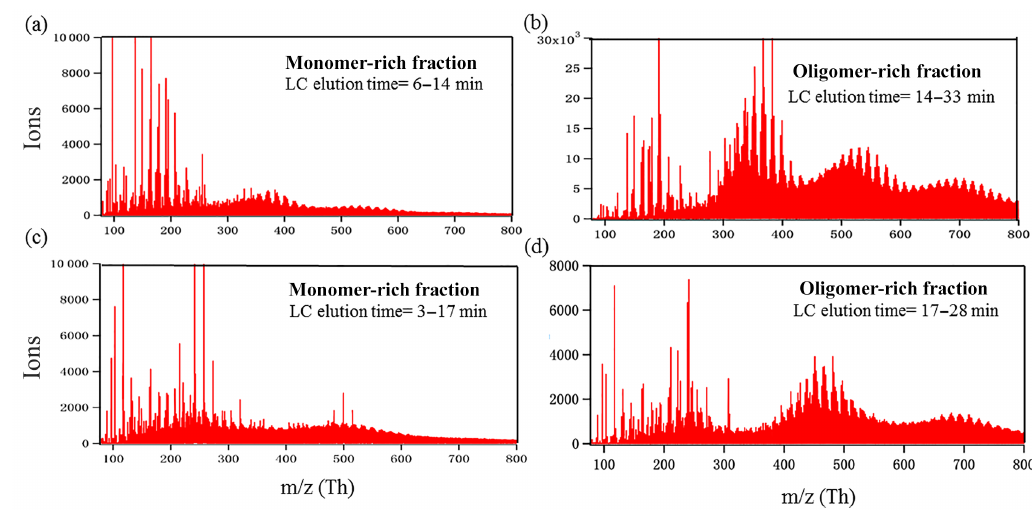
Figure 4. IMS-TOF mass spectra for (a) monomer-rich fraction and (b) oligomer-rich fraction in NSOA, and for (c) monomer-rich fraction and (d) oligomer-rich fraction in PSOA. During a total of 46min elution, the majority of NSOA monomers eluted at 6–14min, and most of the oligomers eluted at 14–33min. For PSOA system, the majority of monomers eluted at 3–17min, and most of the oligomer-rich fraction eluted at 17–28min.